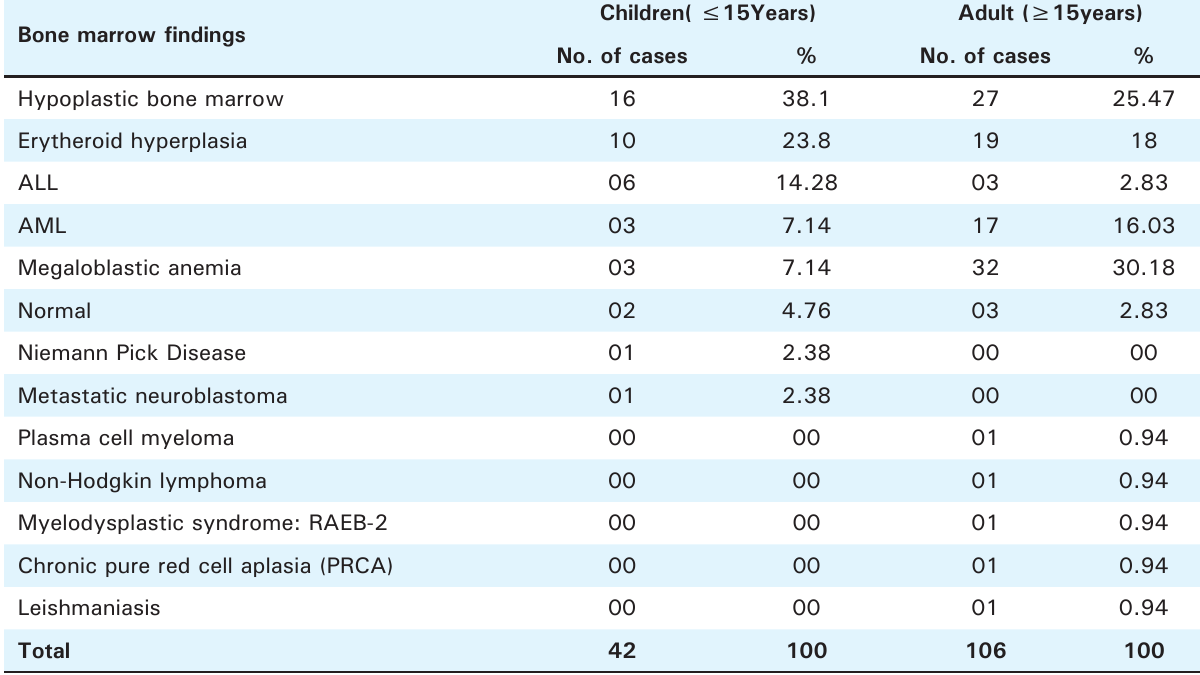
Table 5. Comparison of bone marrow aspiration fi ndings in children and adults Bone marrow fi ndings